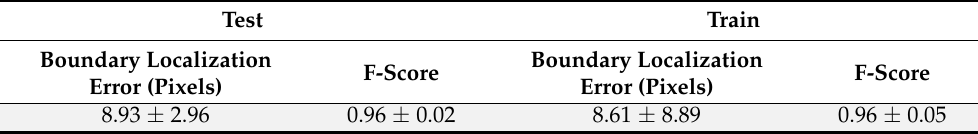
The table entries represent means ± standard deviation obtained in